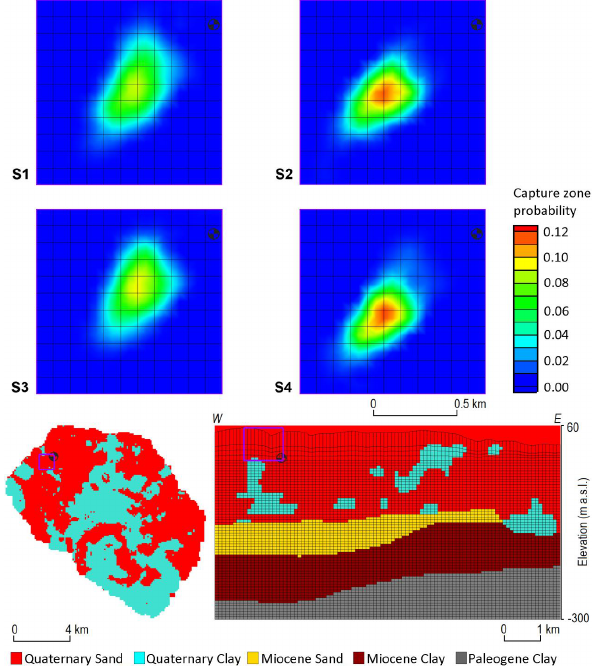
Figure 9: The probabilistic capture zone of Well 1 from each scenario. The well location is 2 Figure 9. The probabilistic capture zone of Well 1 from each sce- illustrated in relation to the geological structure of the TI1. 3 nario. The well location is illustrated in relation to the geological structure of the TI1.